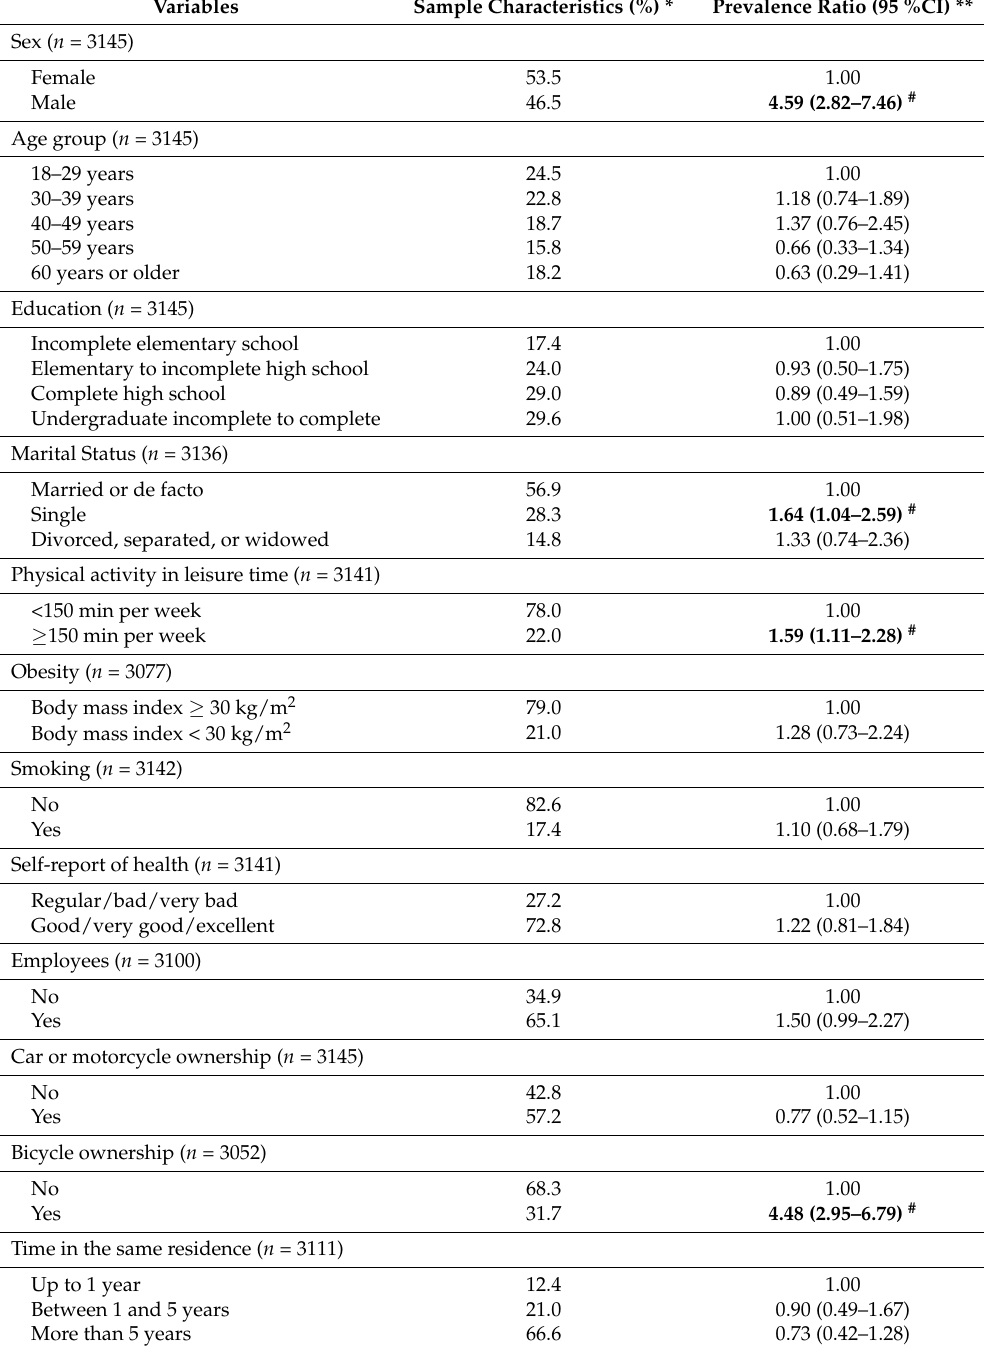
Table 1. Descriptive characteristics and prevalence ratio for cycling for transportation in adults from Sao Paulo,